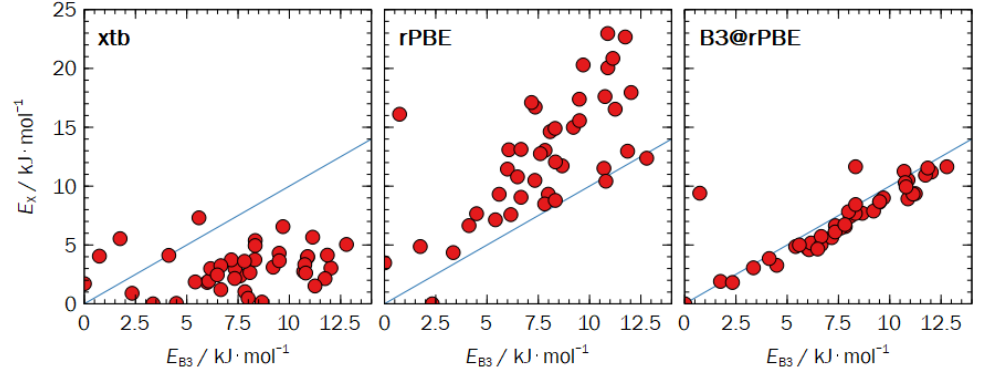
Figure 1. Correlation between 42 calculated S , S -HSerAsn + energies, E x , at various levels of computation with the B3LYP-D3/def2-TZVP energies, E B3 . The blue line indicates that E x = E B3 . From left to right: the GFN2-xTB energies from the CREST (‘xtb’); revPBE-D3/def2-TZVP after geometry optimization (‘rPBE’); and B3LYP-D3/def2-TZVP single-point calculations of the revPBE-optimized structures (“B3@rPBE”).